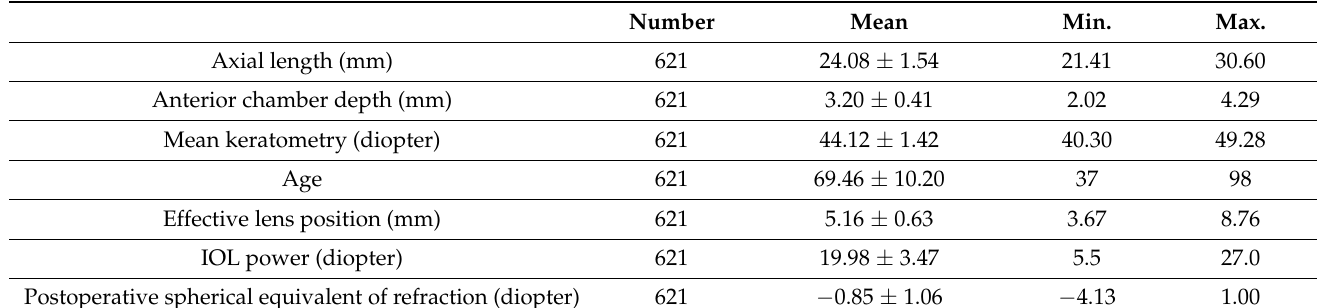
Table 2. Demographic data in this